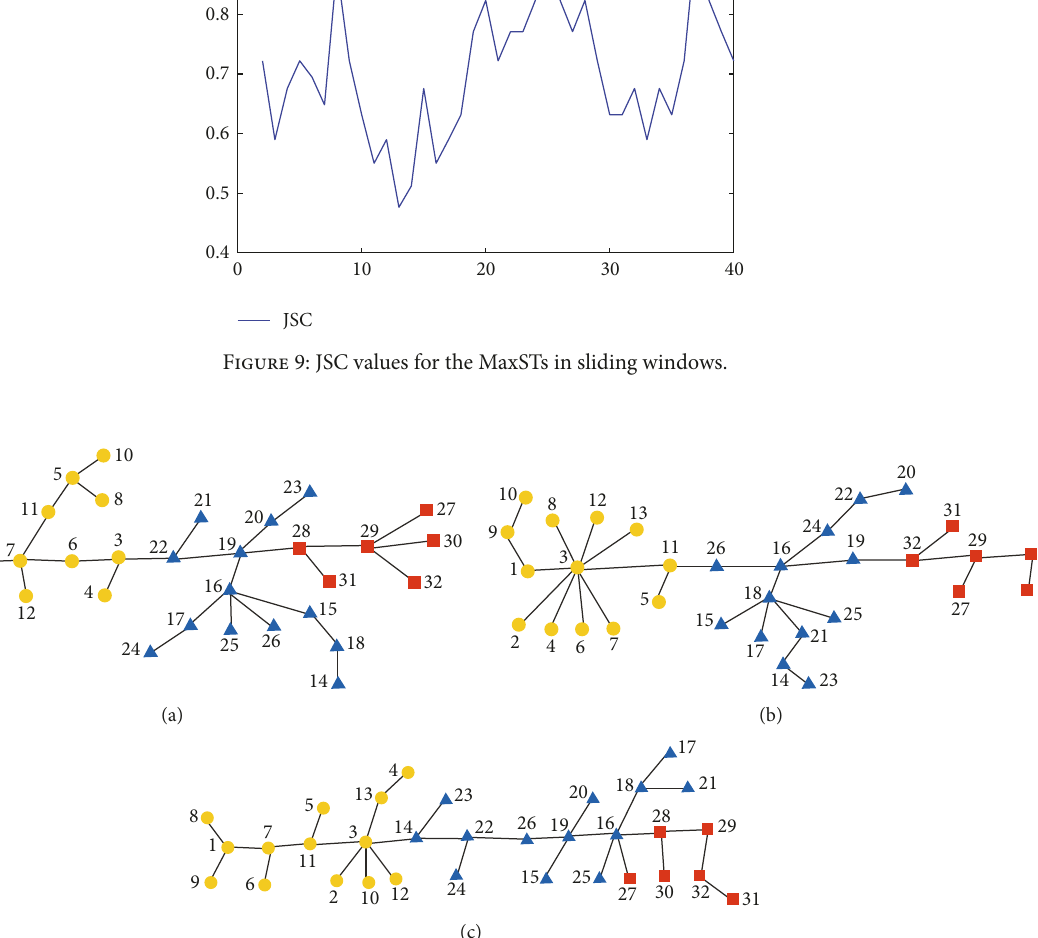
Figure 10: The MaxSTs of the contagion distribution for the entire crisis period using different 𝛼 values in formula (6). (a) MaxST for 𝛼 = 0.01 . (b) MaxST for 𝛼 = 0.1 . (c) MaxST for 𝛼 = 0.15 . Asian and Oceanian markets are shown as yellow circles. European markets are shown as blue triangles. American markets are shown as red